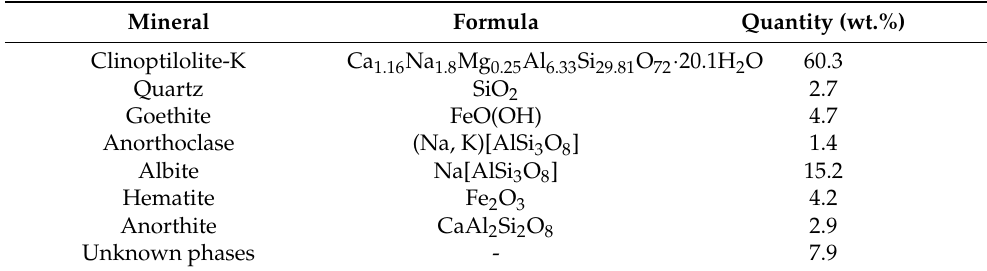
Table 1. The mineralogical composition of natural zeolite. Mineral Formula Quantity